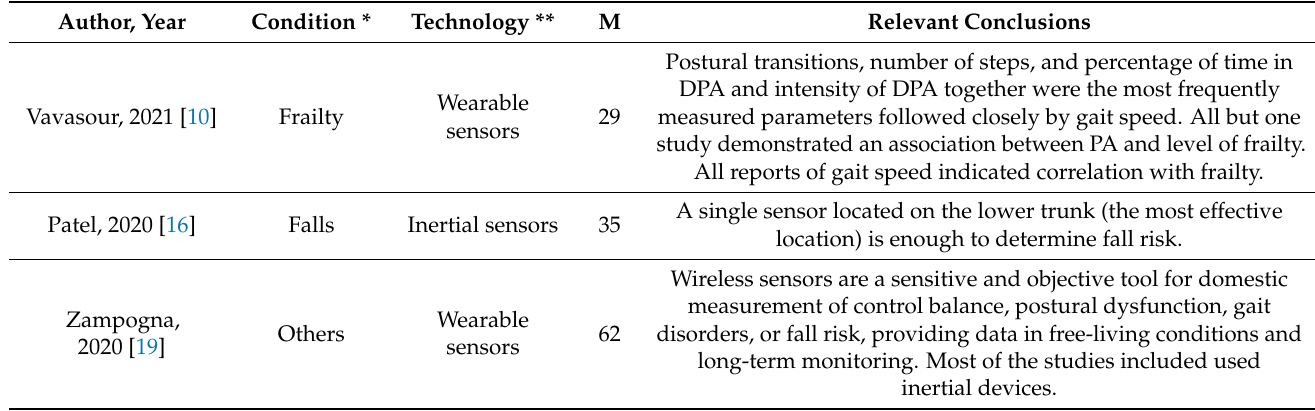
Table 2. Summary of the reviews related to frailty or fall risk and gait analysis in the literature: author, year, patient’s condition, gait analysis technologies included in the article, number of papers included (M), relevant